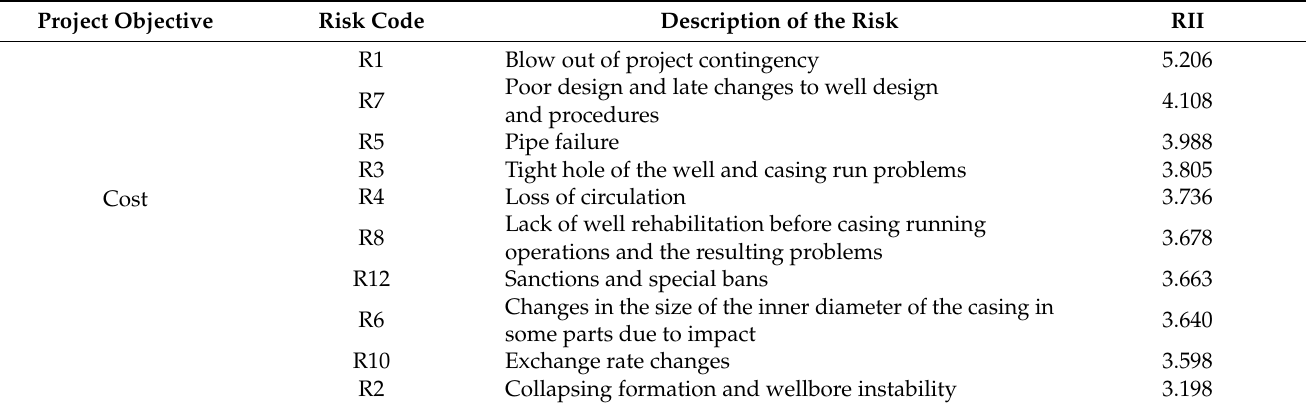
Table 3. The top risks versus each objective of the drilling